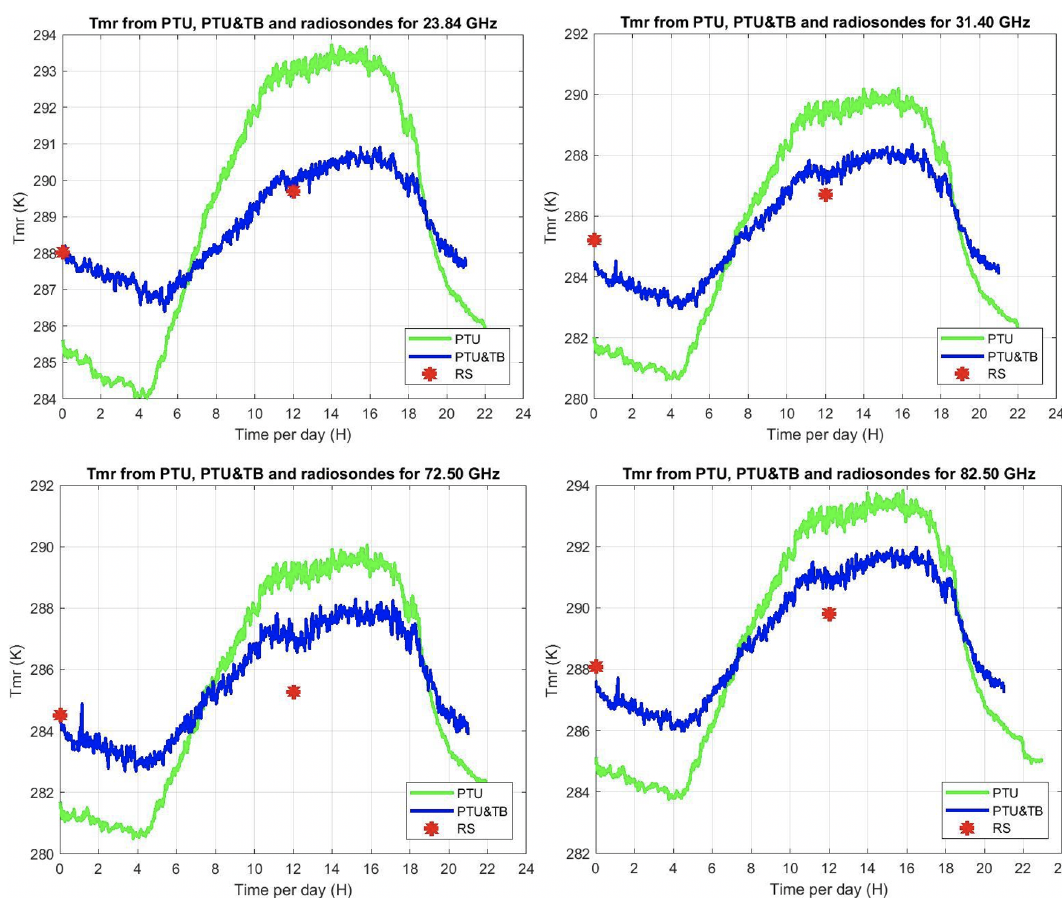
Figure 2. The 24h time series (19 July 2015) of T MR as estimated from surface PTU measurements (green line) and with the additional T B at five V-band channels (blue line). T MR values from twice-daily radiosonde measurements are also reported (red dots). Clockwise from top left: 23.84, 31.40, 72.50,